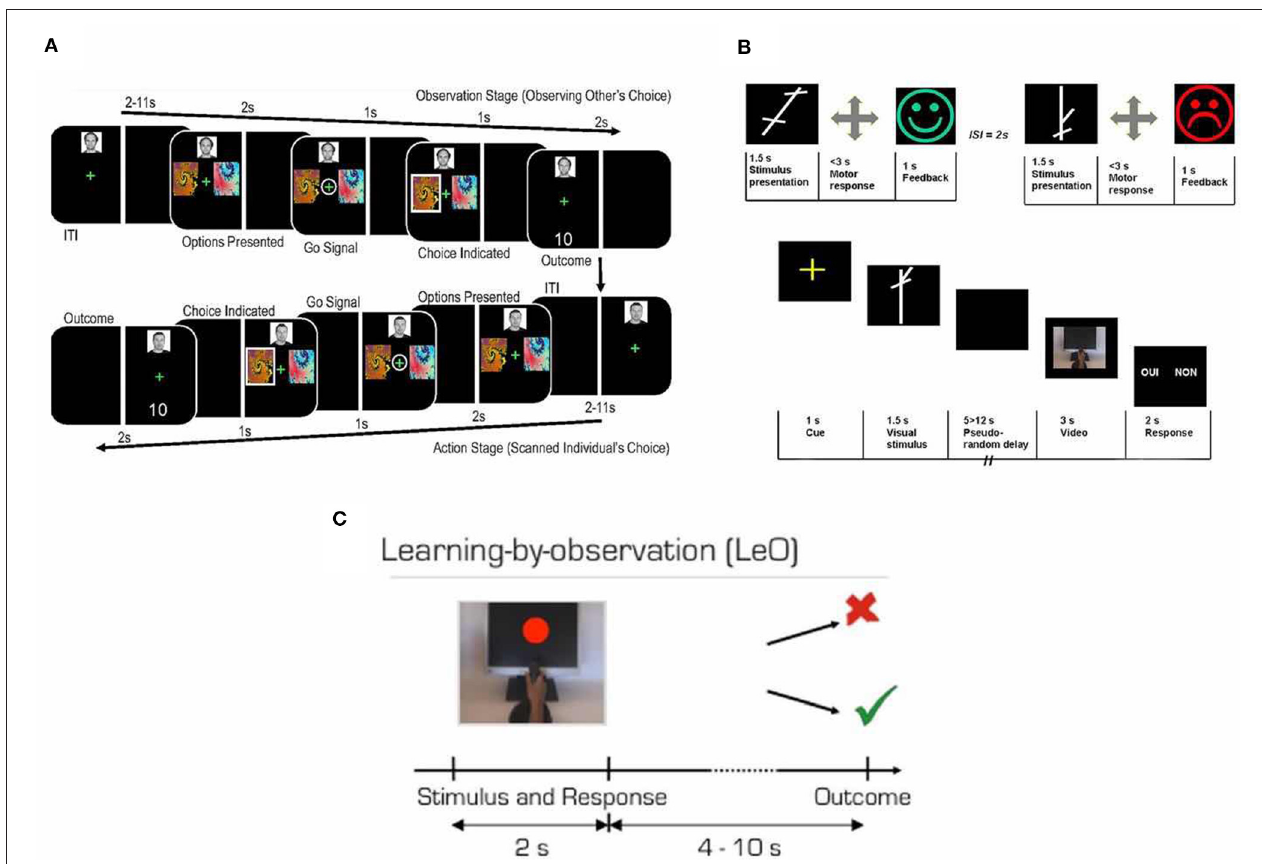
FIGURE 1 | Experimental designs. (A) The upper panel, learning session. Participants learned the associations between abstract visual stimuli and corresponding joystick movements. In the experiment, the stimulus presented on the screen for 1.5s, the participants were asked to move the joystick left, right, up, or down. Once participants made a response, a visual feedback was given to indicate if the response was correct (happy green face; example 1) or wrong (sad red face; example 2). The participants learned one set of S-R associations by trial-and-error exploration and the other by observing experts performing the task. The lower panel, scanning session. Trials in the three different conditions were pseudo-randomly intermixed. Across all conditions, the visual stimuli were presented for 1.5s and followed by a blank screen of variable durations and a short video of an actor’s hand performing a joystick movement. After the movie, participants were asked to judge whether the actor in the video made a correct response or not by pressing a right or left mouse corresponding to “yes” or “no” shown on the left or the right side of the screen, respectively. There was a 50% of change that the actor’s response was correct with 50% of change that the actor’s response was wrong. Adapted from Monfardini et al. (2008) with permission. (B) Prediction error approach paradigm. After a variable ITI, participants first were asked to observe the confederate players being presented with two abstract fractal stimuli to choose from. Then participants were presented with the same stimuli, and the trial proceeded with the same manner. Participants were asked to make a response when the fixation cross was circled by using the index finger for left stimulus and middle finger for right stimulus on the response pad. Adapted from Burke et al. (2010) under Creative Commons Attribution License (CC BY). (C) Each trial started with a video showing a hand on a joystick performing one of the four possible movements in response to the presentation of a colored stimulus on the monitor screen. The total video length was 2s and the colored stimulus lasted 1.5s. The outcome image was presented after a variable delay. Participants were instructed to learn the correct